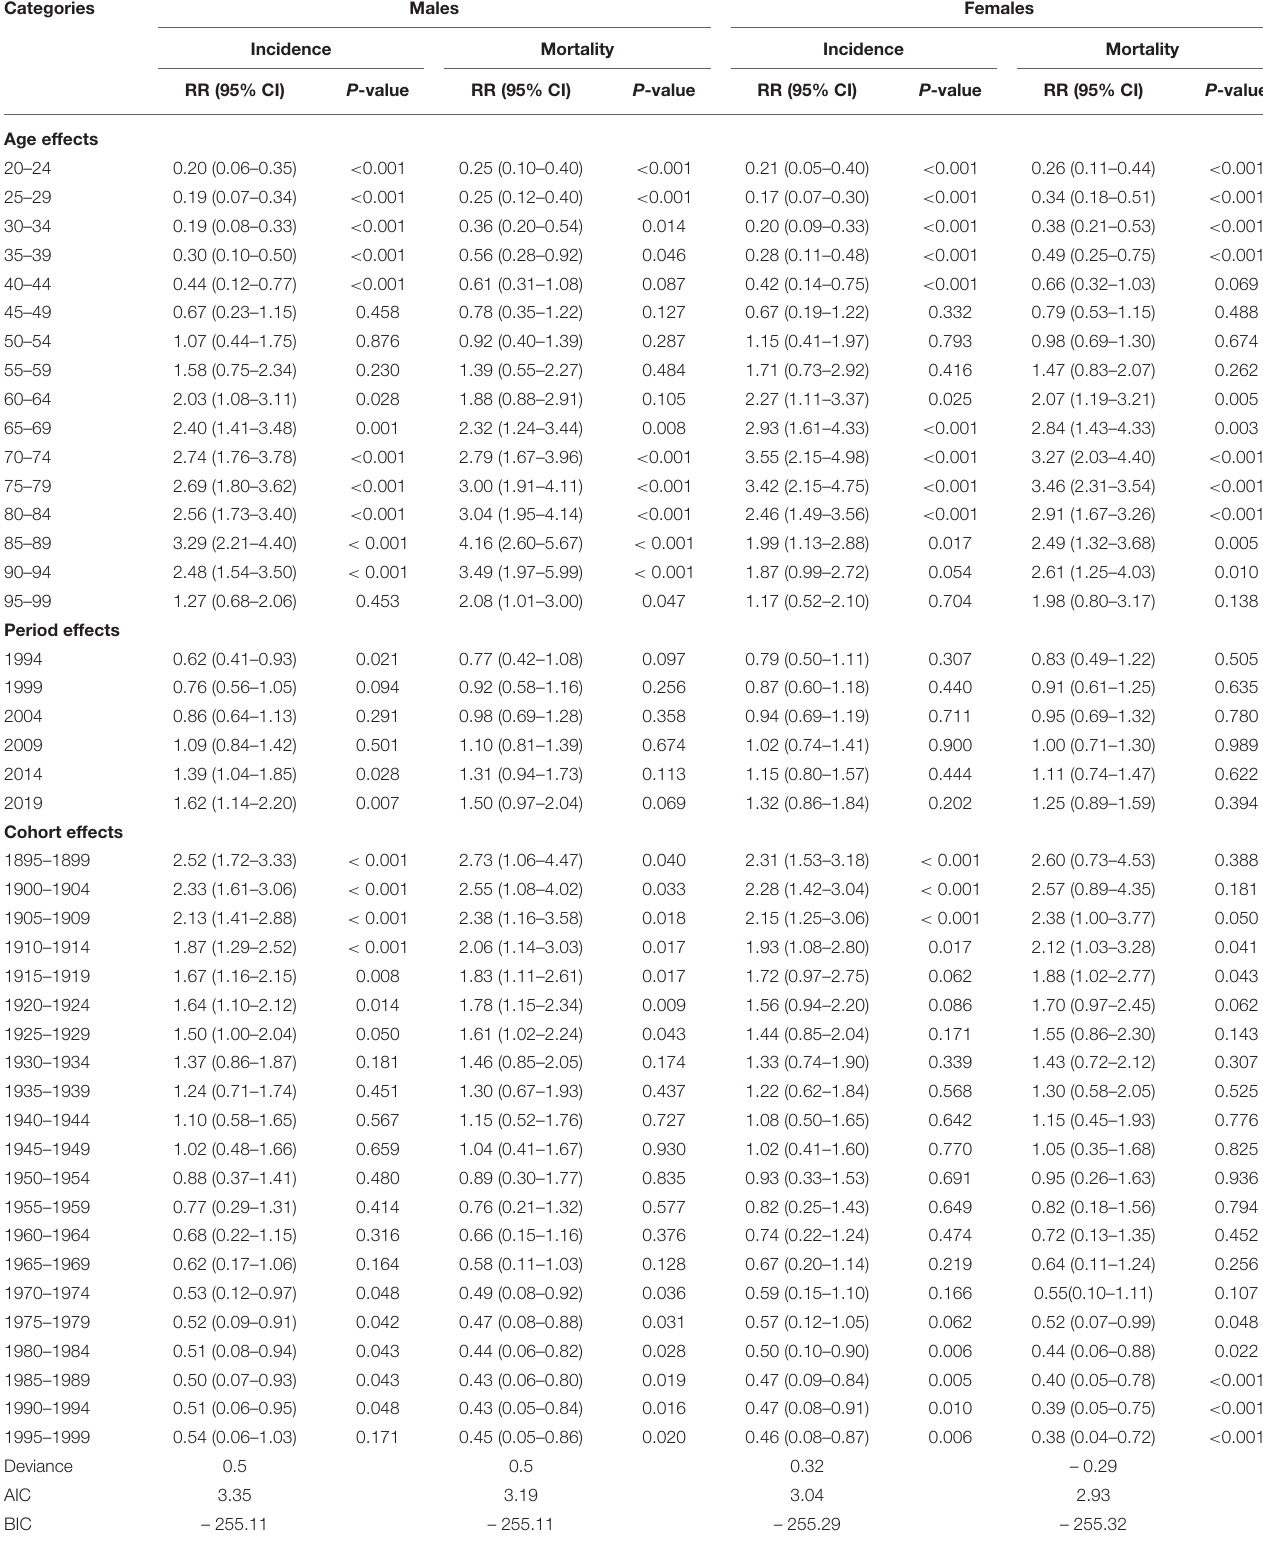
TABLE 2 | Sex – specific relative risks of MM in China due to age, period, and cohort